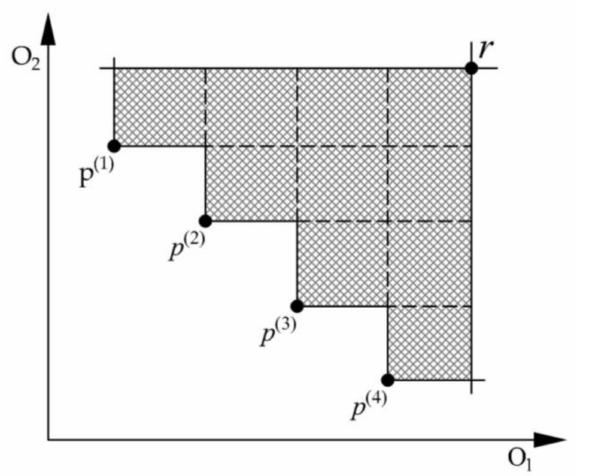
Figure 6. The hypervolume indicator in the case of a two-objective